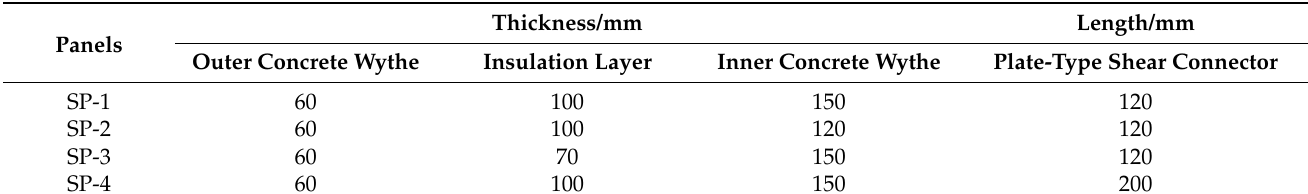
Figure 3. Specimen size and reinforcement: ( a ) SP-1 and SP-4; ( b ) SP-2; ( c ) SP-3.